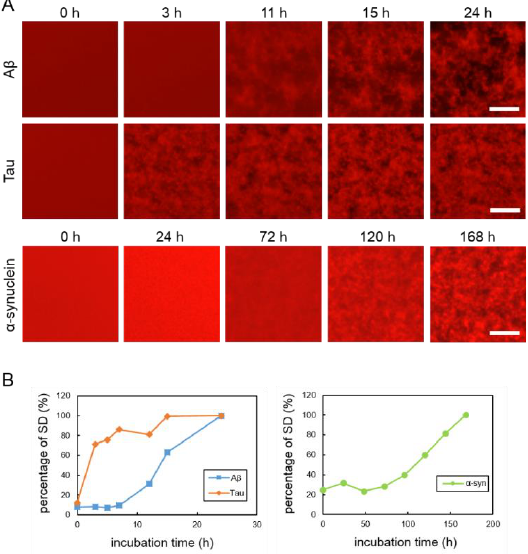
Figure 1. ( A ) Real-time imaging of aggregation processes of various amyloid proteins using QD605. Top: 30- µ M A β , middle: 10- µ M tau, and bottom: 10- µ M α -synuclein with 20% seed. ( B ) Increase of SD values in each amyloid protein. SD values were determined by ImageJ software using the 2D images of A β , tau, and α -synuclein. Data represent the means from three independent samples. Scale bar = 100 µm.